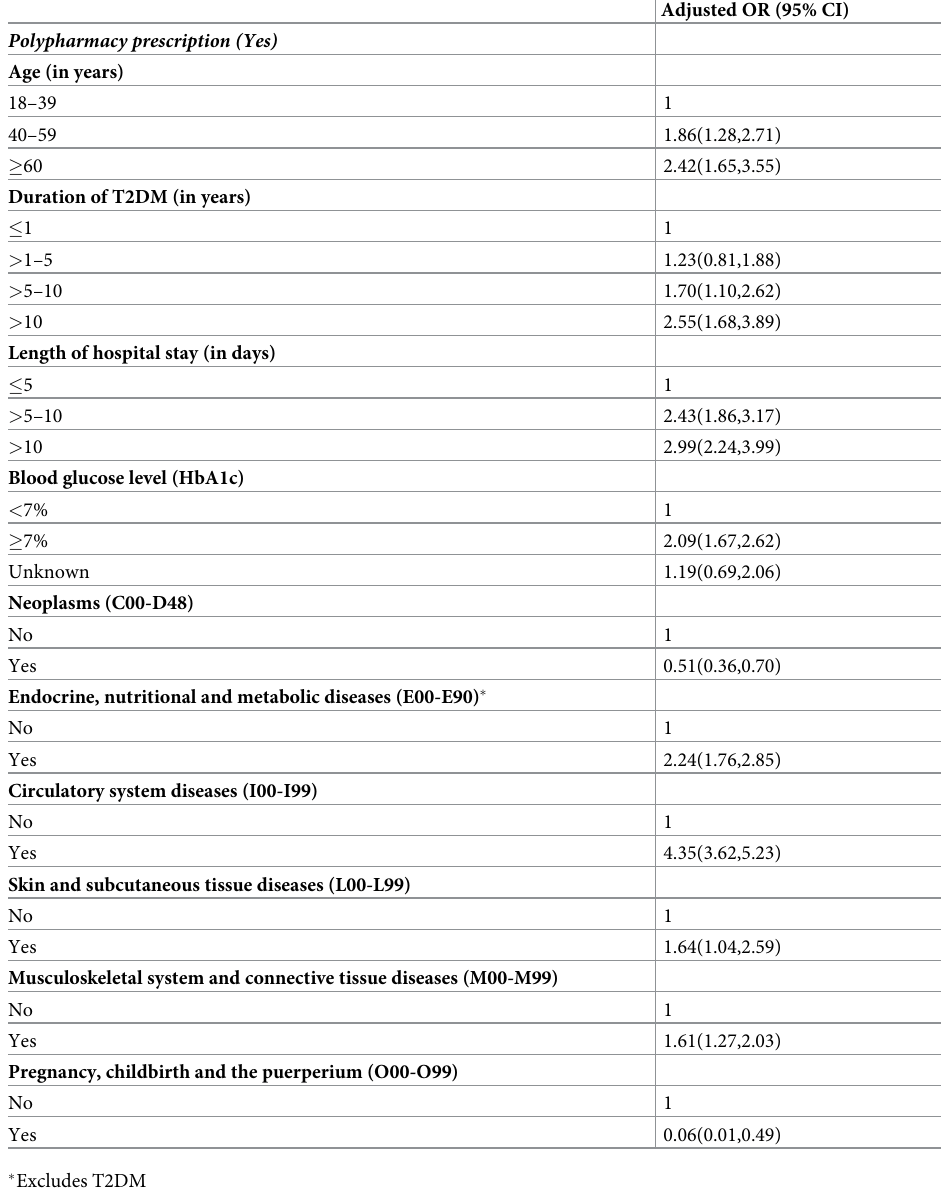
Table 3. Multiple backward stepwise logistic regression analyses to determine factors independently associated with polypharmacy prescription—all the independent variables were